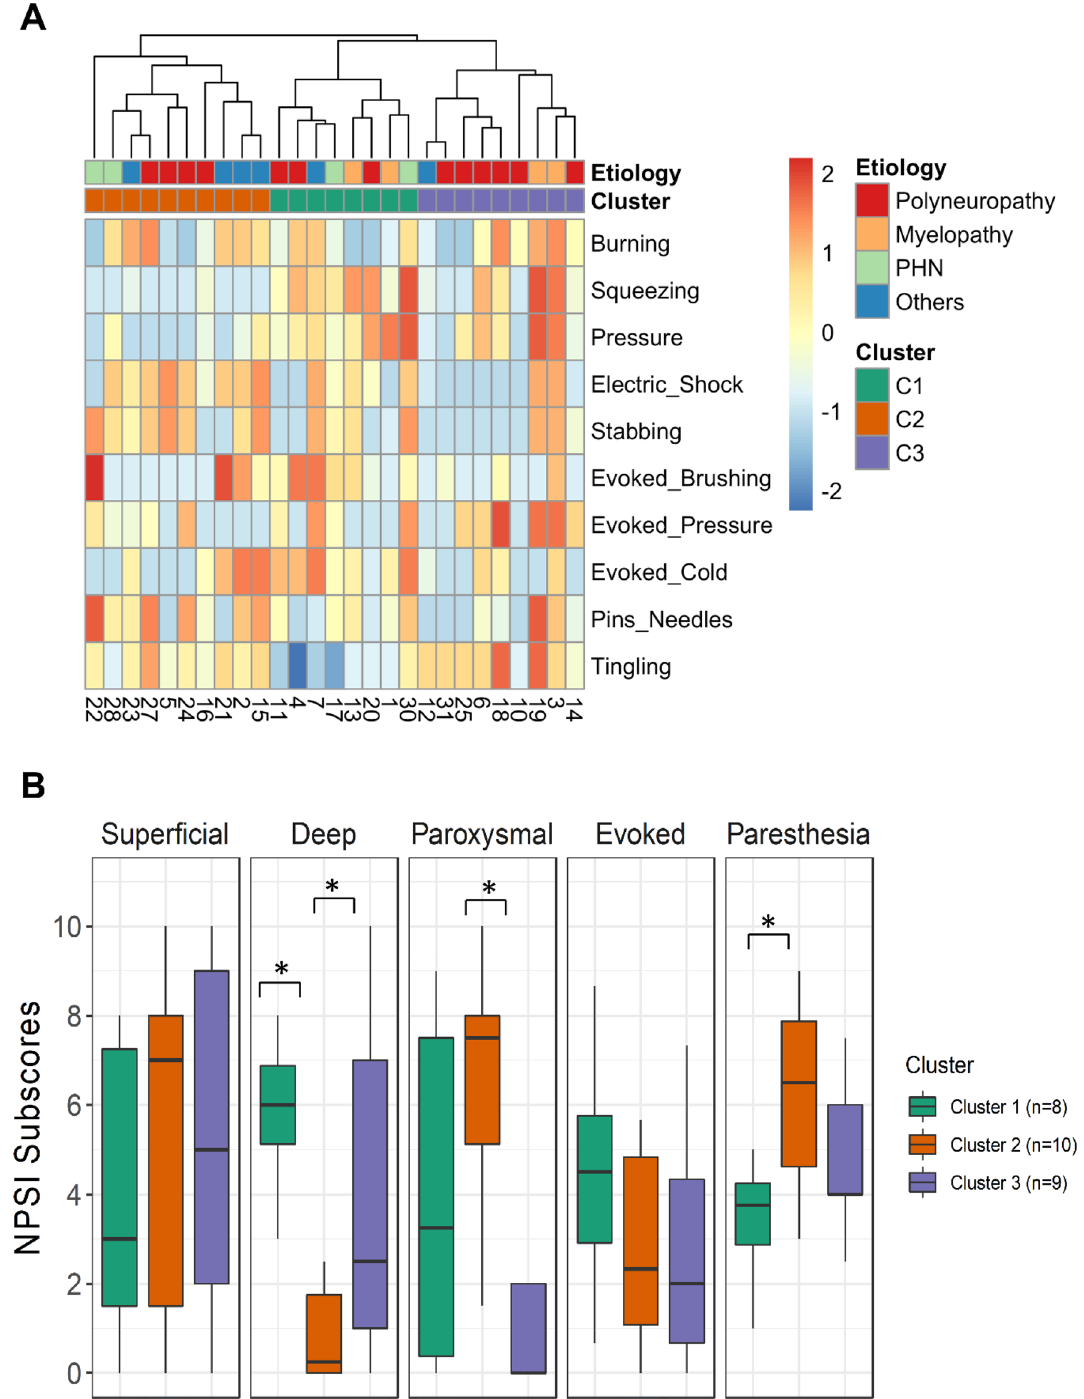
Figure 1. Heatmap Display of the NPSI Profiles ( A ) and Comparisons of the NPSI Subscores by Cluster ( B ). Patient cluster and etiology group membership are indicated by row annotations of different colors above the heatmap and below the dendrogram. Patient clustering was performed on normalized data of the 10 NPSI item scores using Pearson correlation distance and average linkage. NPSI, Neuropathic Pain Symptom Inventory. * indicates statistical significance (p < 0.05,